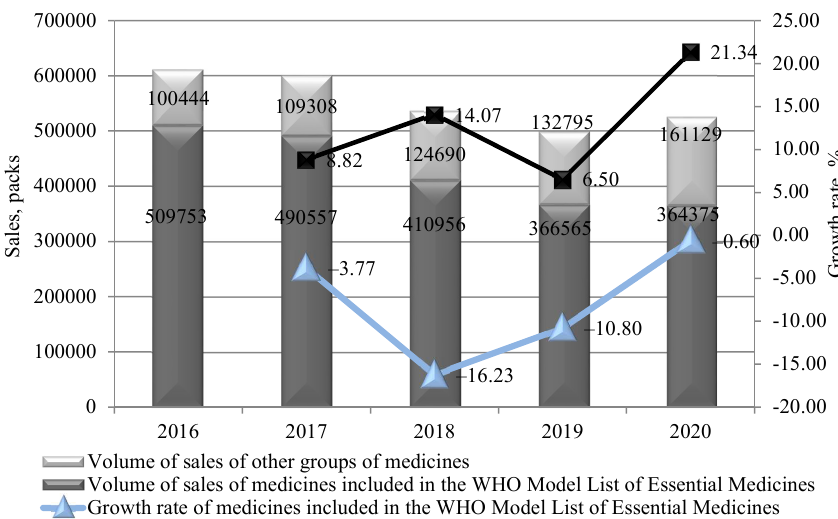
Volume of sales of other groups of medicines Volume of sales of medicines included in the WHO Model List of Essential Medicines Growth rate of medicines included in the WHO Model List of Essential Medicines Growth rate of other groups of medicines Fig. 9. Dynamics of indicators of sales volumes in physical terms of drugs included in the WHO Model List of Essential Medicines and other medicines for the pharmaceutical market of Kazakhstan